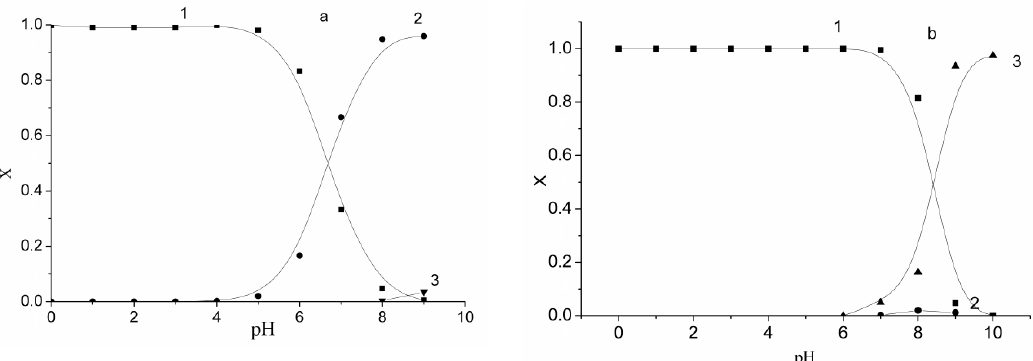
Figure A4. The distribution diagram for chemical species of lead(II) and zinc(II) in the solution as a function of pH ( a ): 1—Pb 2+ , 2—PbOH + , 3—Pb(OH) 2 ; ( b ): 1—Zn 2+ , 2—ZnOH + , 3—Zn(OH) 2 .